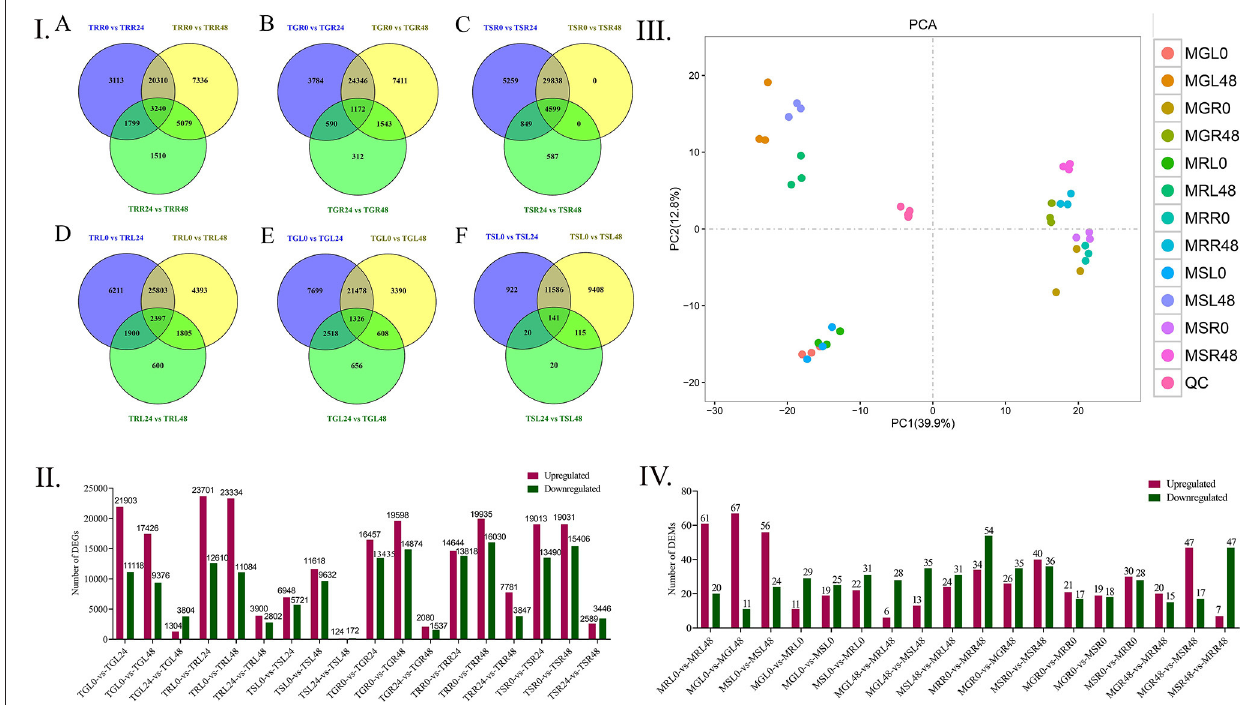
FIGURE 2 | Distribution of DEGs and DEMs in different time points of Gossypium accessions. (I) Gene distributions among different materials, A Differential gene distribution among different comparison groups of MG85 leaves. B Differential distribution of LT40 gene among different comparison groups. C Gene distribution among different comparison groups of CRI12 leaves, D MG85 differences between different comparison groups Gene distribution, E LT40 differential gene distribution among different comparison groups, F CRI12 differential gene distribution among different comparison groups. (II) Number of DEGs identified by pairwise comparisons between cotton lines and drought treatments. Upregulated (Red) and downregulated genes were quantified. Based on |log2 (fold change) > 1| and p < 0.05 were considered as significantly differential genes. (III) Principal Component Analysis Model, where MRL, Marie- galantie85 leaves; MRR, Marie-galantie85 Root; MGL, upland cotton leaf; MGR, upland cotton root; MSL, Lattifolium40 leaf; MSR, Lattifolium40 Root. (IV) Differentially Expressed Metabolites, upregulated (Red) and downregulated genes were quantified. LC-MS metabolite analyses were used to detect the metabolites from leaf and root tissues. DEGS, differentially expressed genes; DEMs, differentially expressed metabolites; LC-MS, Liquid chromatography-Mass